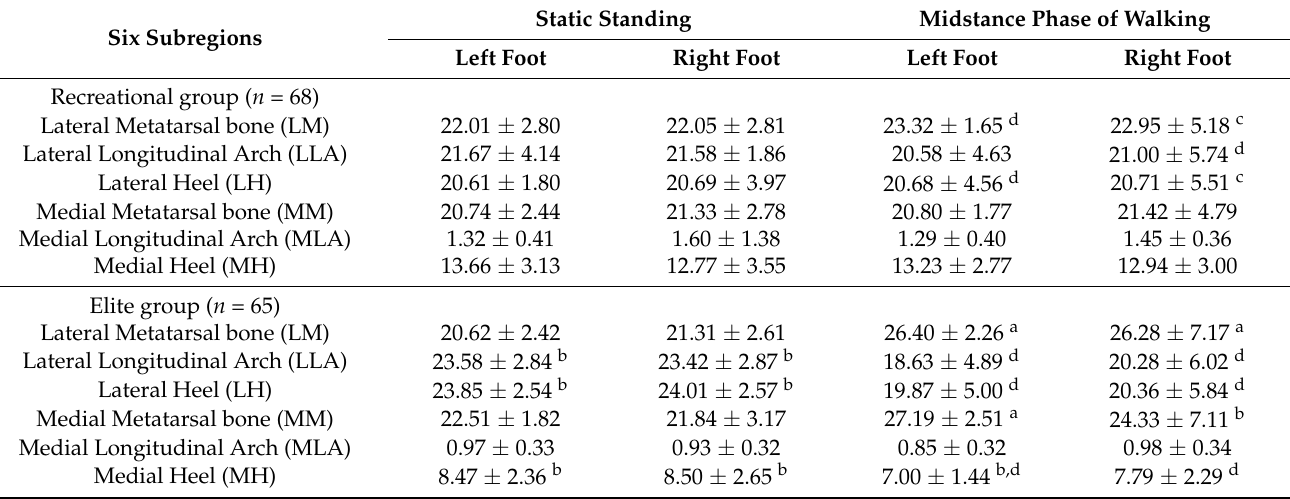
Table 4. Bipedal plantar pressure distributions of the six subregions under static and dynamic states. Static